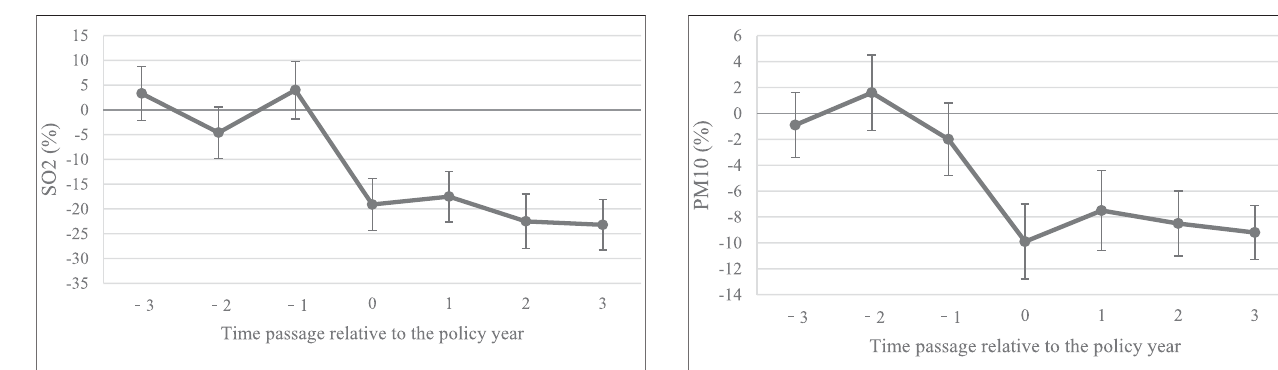
FIGURE 7 | The parallel trend test for the SO 2 .